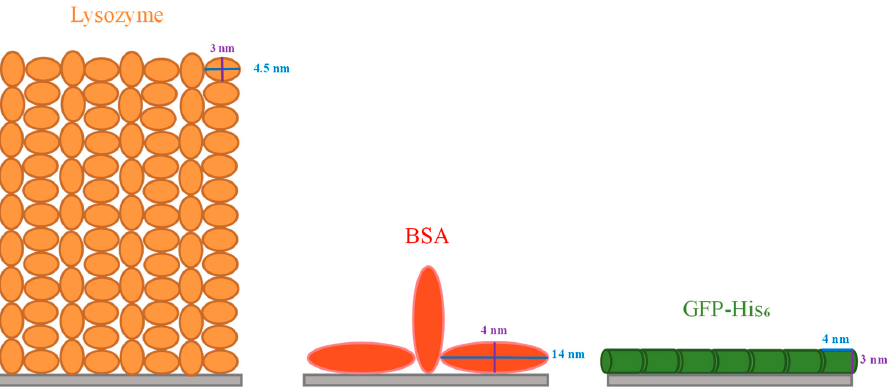
Figure 7. Schematic illustration of possible protein adsorption arrangements on the IMAM.